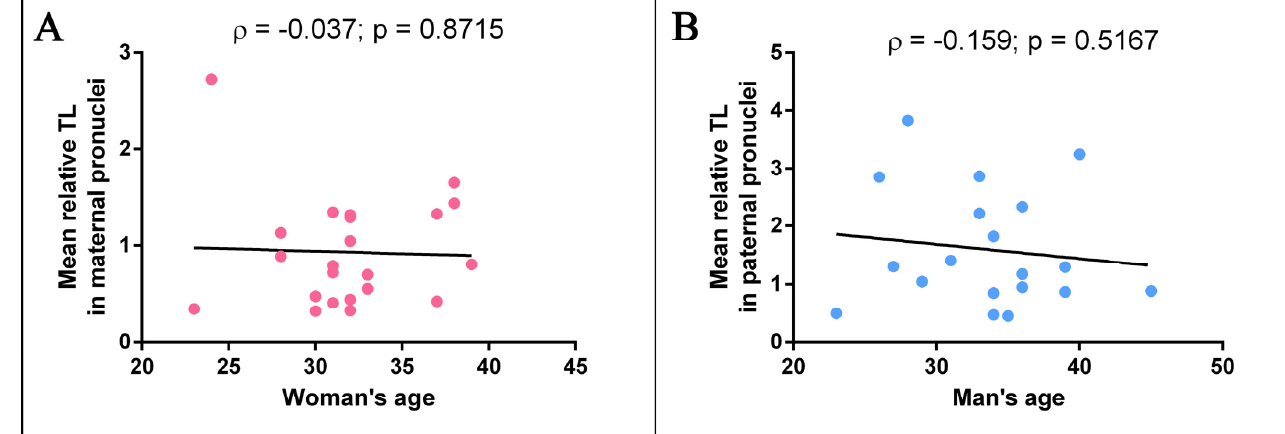
Figure 4. The relationships between telomere length (TL) in metaphase chromosomes from human triploid zygotes and the parents’ age. Scatter plot of the mean relative TL in paternal chromosomes and paternal age: the correlation is not statistically significant ( ρ = − 0.159, р = 0.5167, Spearman test) ( A ). Scatter plot of the mean relative TL in maternal chromosomes and maternal age: the correlation is not statistically significant ( ρ = − 0.037, p = 0.8715, Spearman test) ( B ).